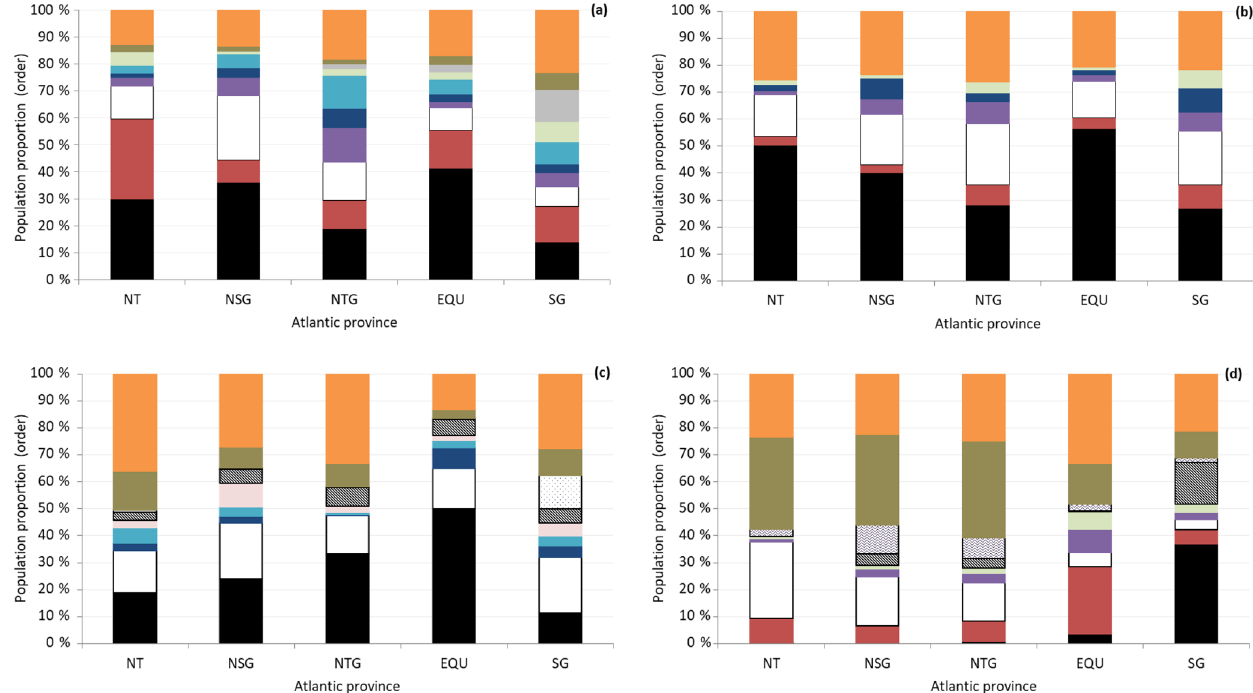
Figure 5. Changes in bacterial community composition (order, identified using 16S rRNA gene sequencing) for (a) 97% PAR surface 5m, (b) 33% PAR 10–31m, (c) 1% PAR 15–54m and (d) 200m for different provinces (NT, NSG, NTG, EQU and SG) of the Atlantic Ocean. Analysis is based on a rarefied sample of 386 sequences per sample. Bacterial orders individually contributing to less than 5% of the total sample sequences were pooled together into “Others (<5%)” for clarity. Where Prochlorococcus , Alteromonadales , SAR11 clade, Oceanospirillales , Rhodospirillales , Flavobacteriales , Rhodobacterales , Sphingomonadales , Synechococcus , Acidimicrobiales , Order III Incertae Sedis , SAR324 clade (marine group B), uncultivated bacterium and other bacteria individually comprising